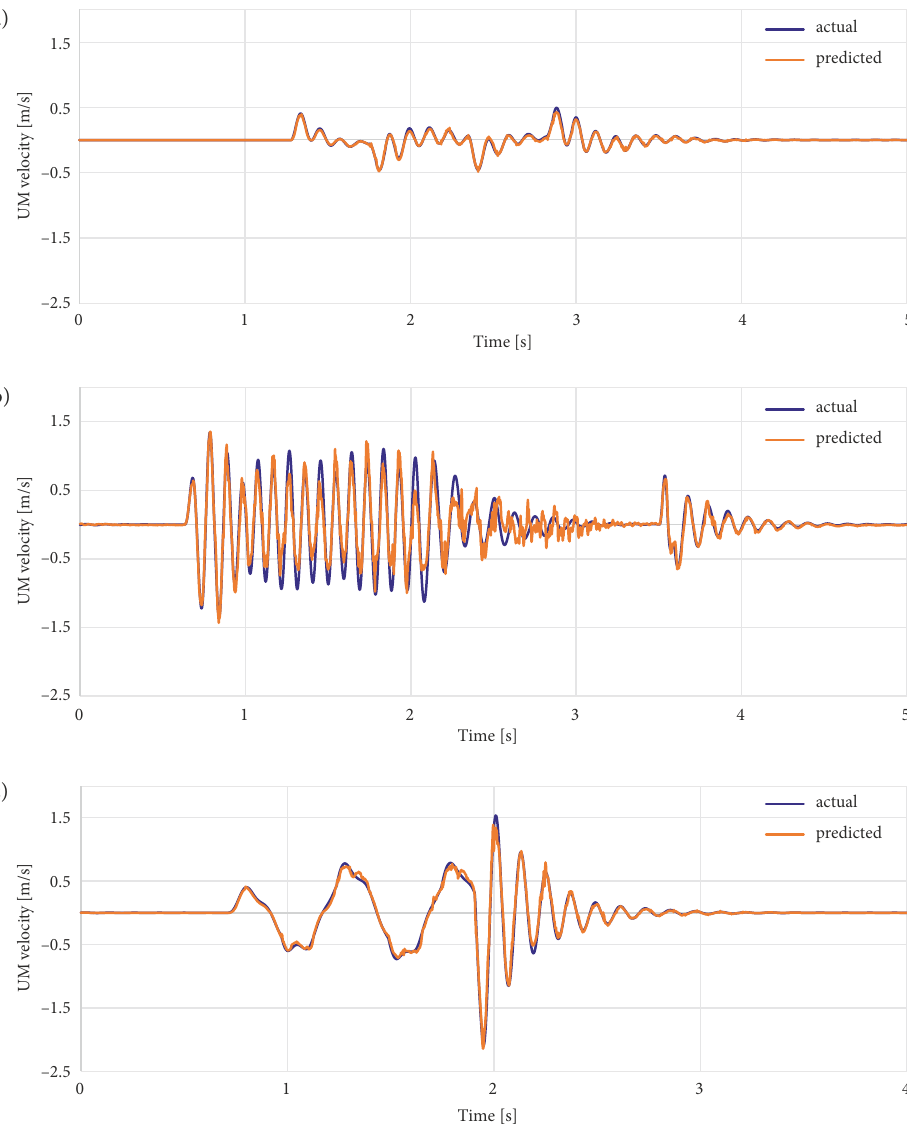
Figure 5. Signal repeatability with VS for specified wheel: a – trapezoidal road bumps test (25 km/h); b – sinusoidal road profile test (40 km/h); c – road with pits (20